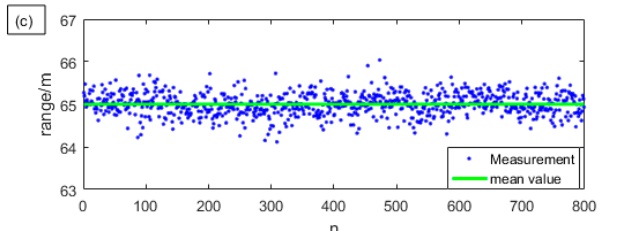
Figure 6. The measurement results are listed as: (a) I signal. Number of valid results: 536, average value: 65.1 m. Standard deviation: 0.48 m, probability of detection: 67%; (b) Q signal. Number of valid results: 514, average value: 65.07 m. Standard deviation: 0.42 m, probability of detection: 64.25%;